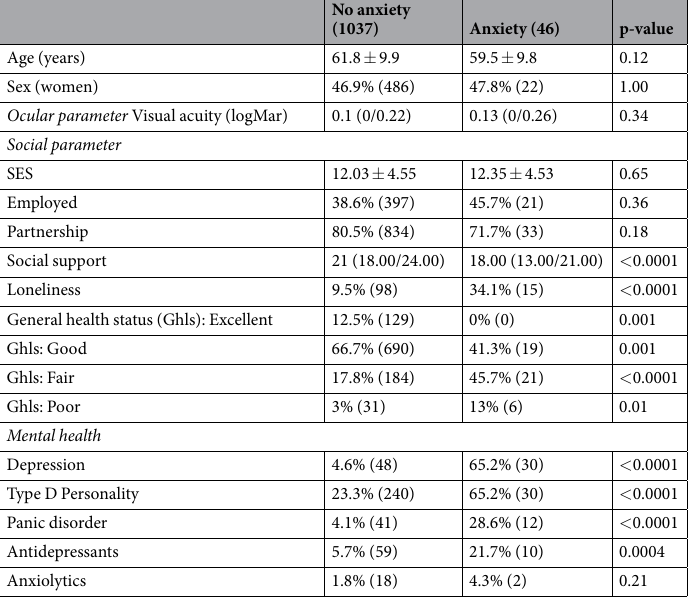
Table 10. Study characteristics of AMD participants with and without anxiety. Abbreviations: Glhs (general health status), SES (socioeconomic